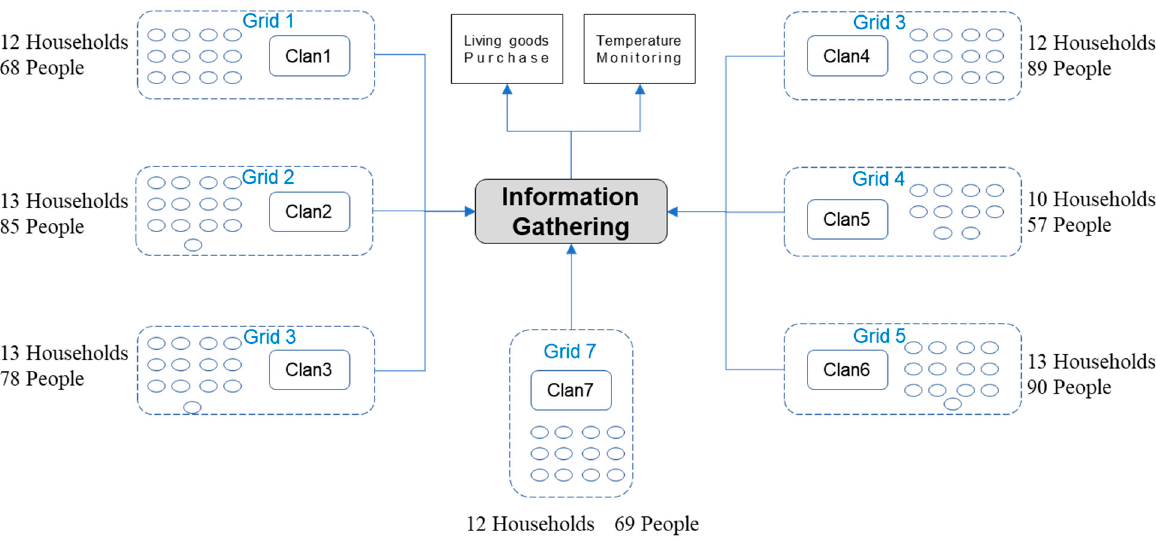
Figure 3. Distribution of Quanjingwan community grids based on clanship.